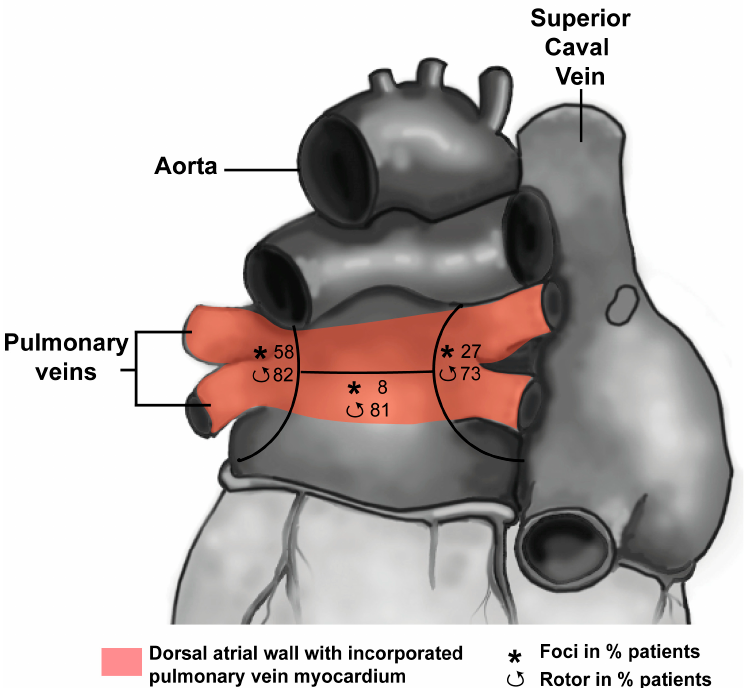
Figure 3. Distribution of drivers (focal breakthroughs, asterisk; reentry events, curved arrows) in three regions is reported as the percentage of patients (Redrawn from [40]). The pink area indicates the continuum of the left atrial dorsal wall and pulmonary veins after incorporation (for explanation see text). Note that ectopic foci are nearly absent in the roof of the left